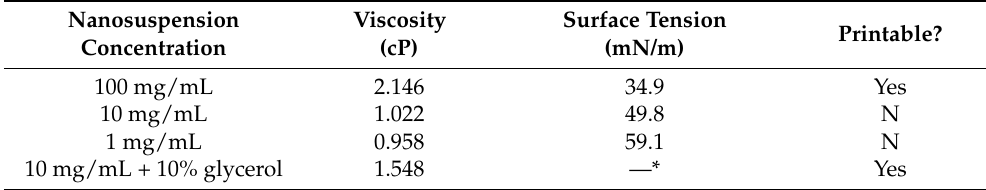
Table 1. Amenability of nanosuspensions formulations of varying concentration and viscosity for inkjet printing.